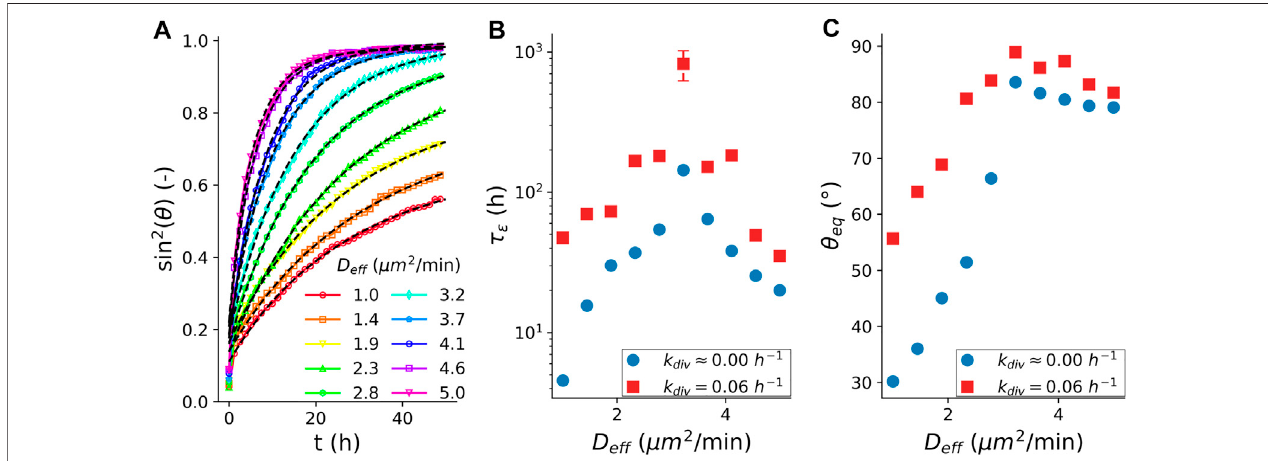
FIGURE4| Fusioncharacteristicsinthepresenceofcelldivision. (A) Average(N (cid:1) 100)fusiondynamicswithsimulatedcellcycle,quanti fi edassin 2 ( θ ) ,during50 h for varying cell activity D eff at constant w r (cid:1) 2 . 09min − 1 and k div (cid:1) 0 . 06h − 1 . The simulated data is fi tted by calculating sin 2 ( θ ) based on the solution for θ Eqs. 2 , 3 . Although cell division is not taken into account in the fusion dynamics model, it still fi ts the data well. Fitting results of have to be interpret as effective parameters. (B – C) Comparison of fusion dynamics characteristics in presence and in absence of cell division, as a function of cell activity D eff at a constant w r (cid:1) 2 . 09min − 1 . The estimated values for the visco-elastic time constant τ ε are based on fi tting the average fusion dynamics in sin 2 ( θ ) using Eqs. 2 , 3 , the predicted equilibrium angle θ eq calculatedby Eq.4 .Theerrorbarsfor τ ε correspondtotwotimesthestandarderrorobtainedfromthe fi ts.Inthesegraphs,theerrorbarsareonlyonetimelargerthanthe marker. These graphs show that cell division promotes spheroid fusion, although the system remains arrested at low levels of cell activity.